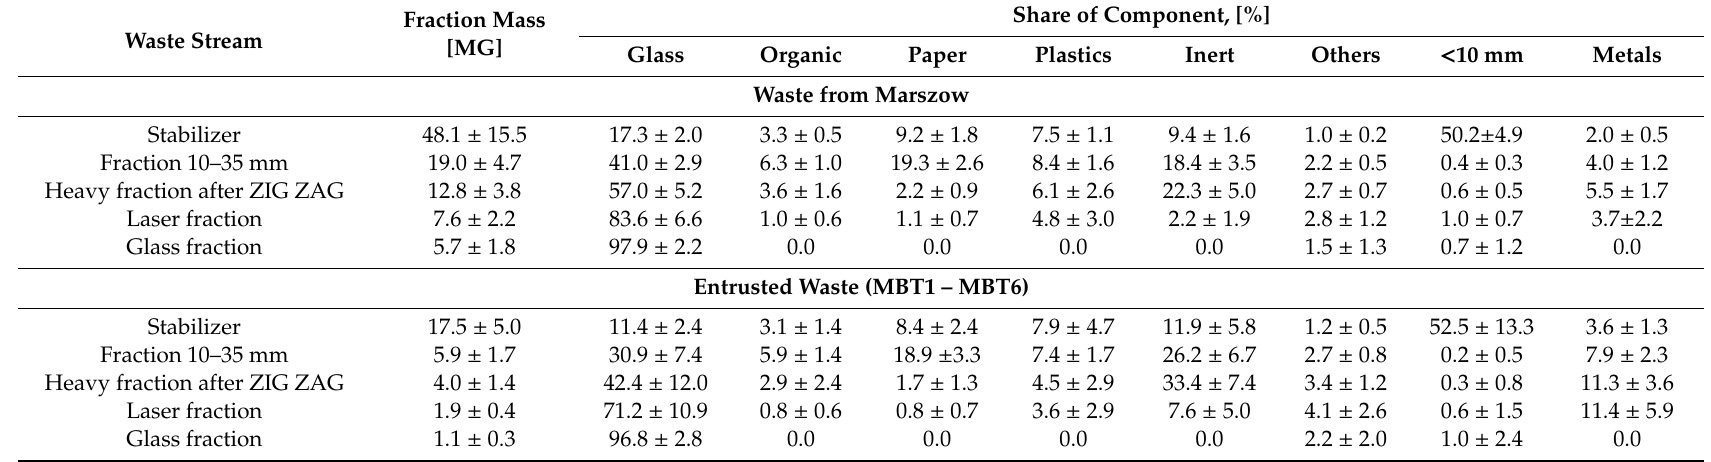
Table 2. Mass and material composition of intermediate products obtained in the subsequent stages of the process of treating the stabilizer from Marsz ó w and that collected from other MBT installations on the glass concentrate production